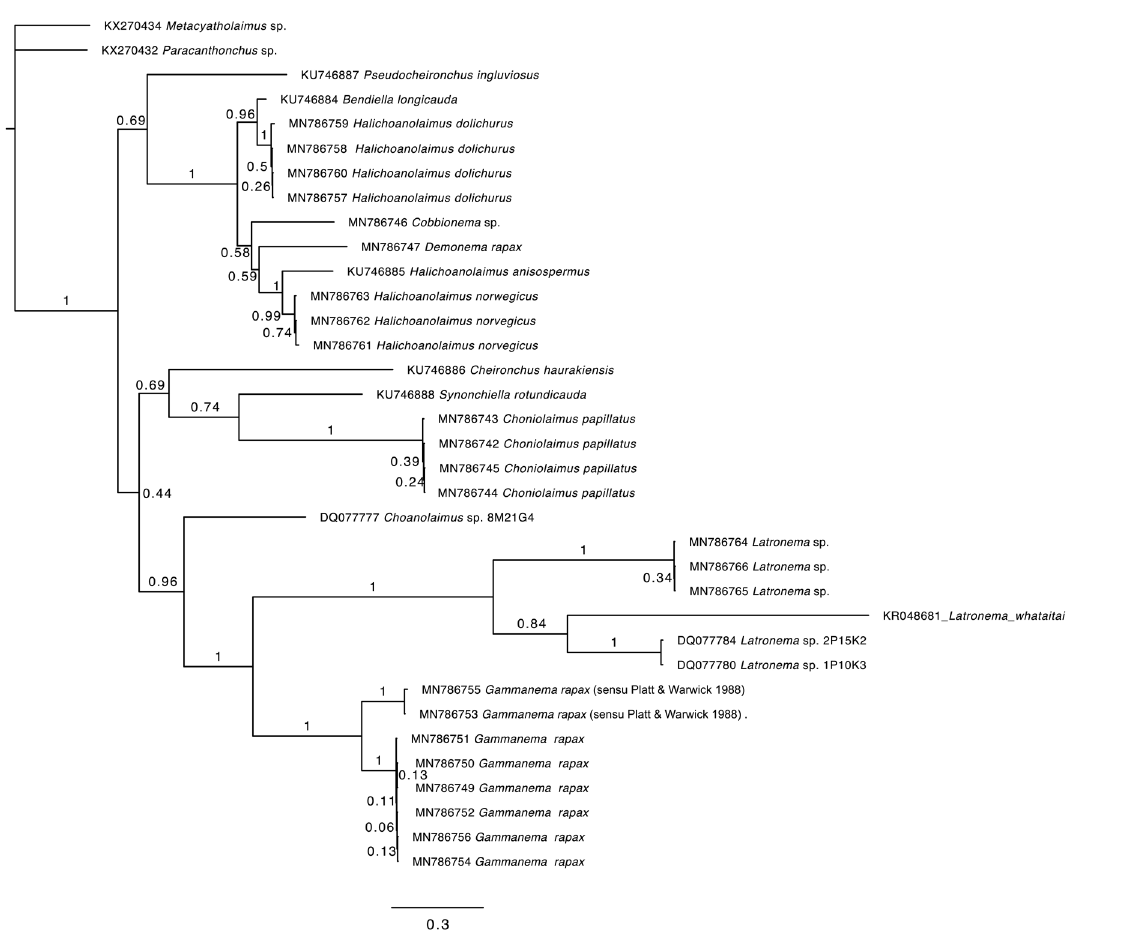
Fig. 13. Bayesian phylogenetic tree of Selachinematidae Cobb, 1915 inferred from 28S rRNA data, using alignments based on secondary structure models using REV GAMMA for unpaired sites and RNA16A for paired